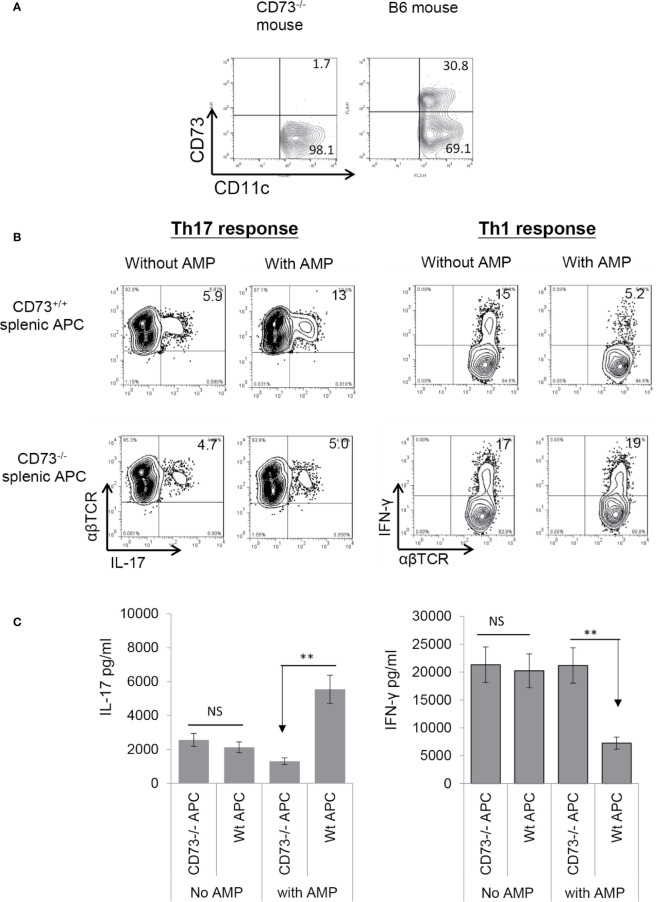
Adenosine monophosphate enhanced Th17 responses and inhibited Th1 responses in the presence of CD73+ splenic APCs (A). Approximated one third of the splenic CD11c+ cells of B6, but not CD73−/− mouse expressed CD73. Splenic cells of B6 and CD73−/− mouse were double stained by FITC-anti-CD11c and PE-anti-mouse CD73. The staining profile of gated CD11c+ cells is shown (B). MACS column separated αβ T cells from immunized B6 mice were stimulated for 5 days with the immunizing peptide and antigen presenting cells under either Th17 (left panels) or Th1 (right panels) polarizing conditions; then the numbers of IL-17+ and IFN-γ+ cells among the TCRαβ+ responder T cells was assessed after intracellular staining with anti-IL-17 and anti-αβTCR mAbs. Upper panels are the responses stimulated by CD73+/+ splenic APCs and lower panels are responses stimulated by CD73−/− splenic APCs (C). ELISA assays for IL-17 and IFN-γ production by responder αβ T cells after 48 h stimulation by the immunizing antigen and CD73+/+ or CD73−/− splenic APCs. CD73+/+ and CD73−/− BMDCs, with or without a prior treatment of splenic APCs with adenosine monophosphate. The data are from one single experiment and are representative of those obtained in three independent experiments. ns, not significant.